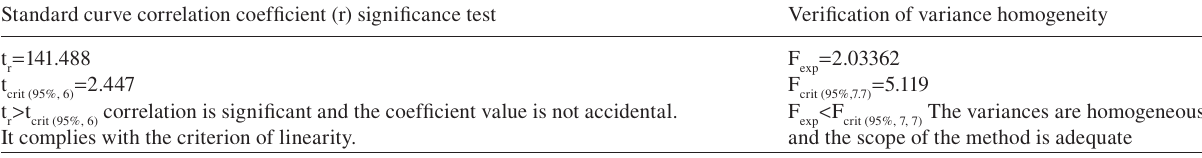
Table 4 Results of standard curve correlation coeffi cient signifi cance test and verifi cation of variance homogeneity. Standard curve correlation coeffi cient (r) signifi cance test Verifi cation of variance homogeneity